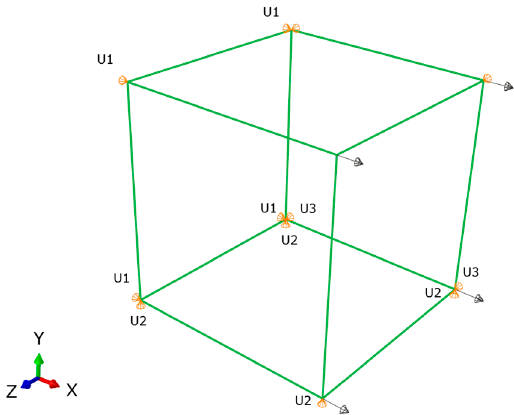
Figure 7. One-solid-element finite element model used in the validation.